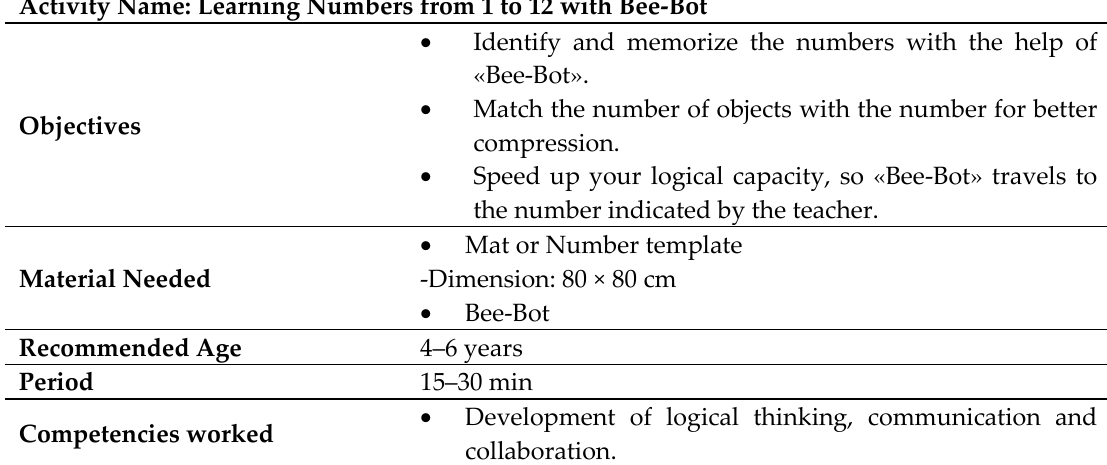
Table 1. Activity